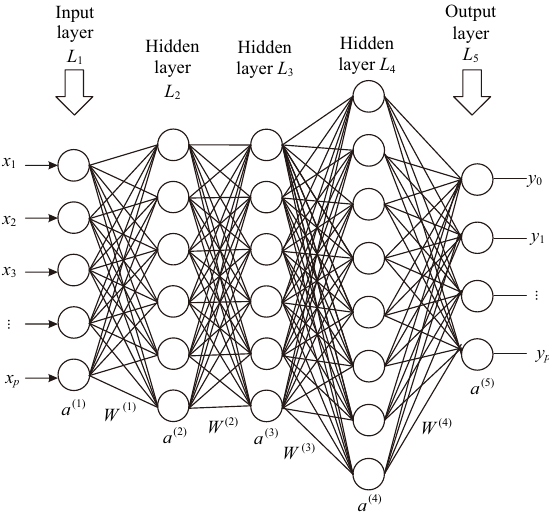
Fig. 2 Feed-forward DNN with 3 hidden layers.